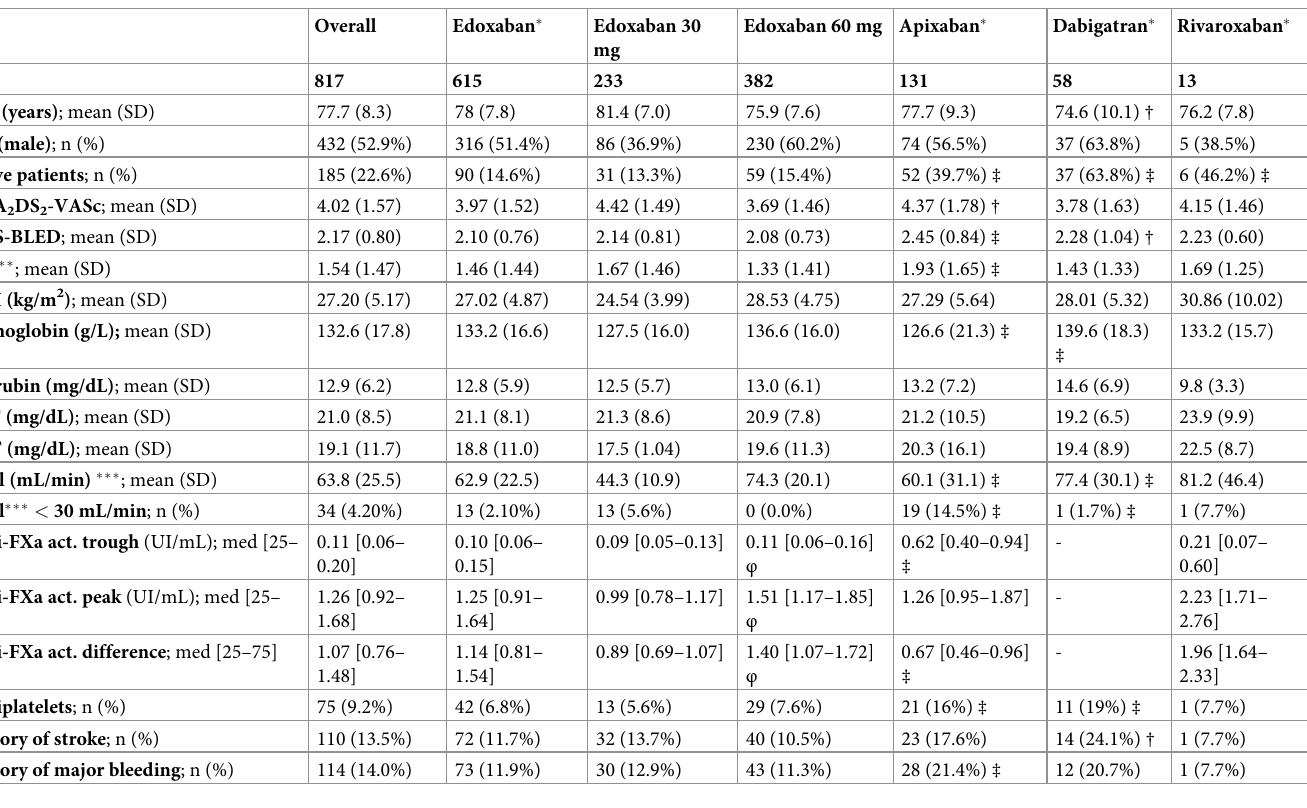
Table 1. Baseline clinical characteristics according to DOAC